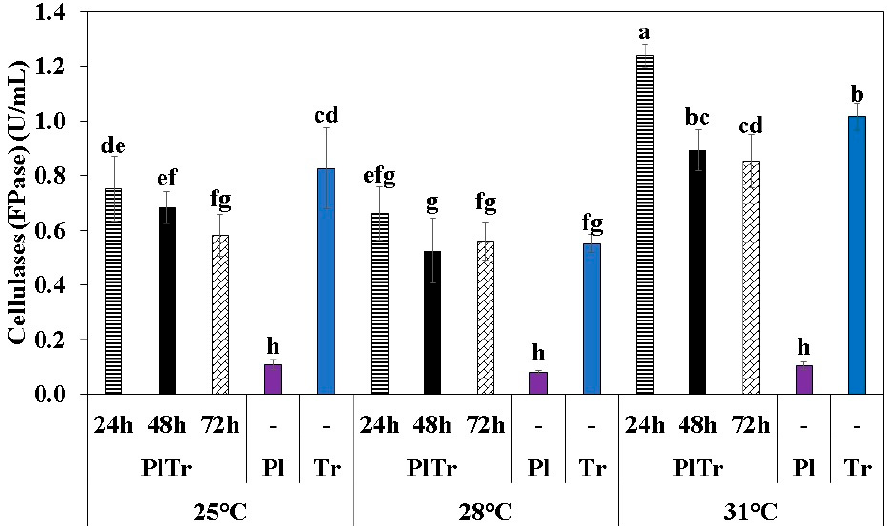
Figure 2. Enzymatic activities of cellulases (FPase) obtained in submerged fermentation using Mandels & Weber medium with oil palm decanter cake (OPDC) as carbon source. The co-cultures were carried out by adding T. reesei (Tr) to 24, 48, and 72 h old monocultures of P. lecomtei (Pl). The experiments were carried out at three different temperatures, 25, 28, and 31 °C, for 8 days. The monocultures of Tr and Pl were used as controls. Different letters over the bars mean significant differences ( p < 0.05) according to the Tukey test.